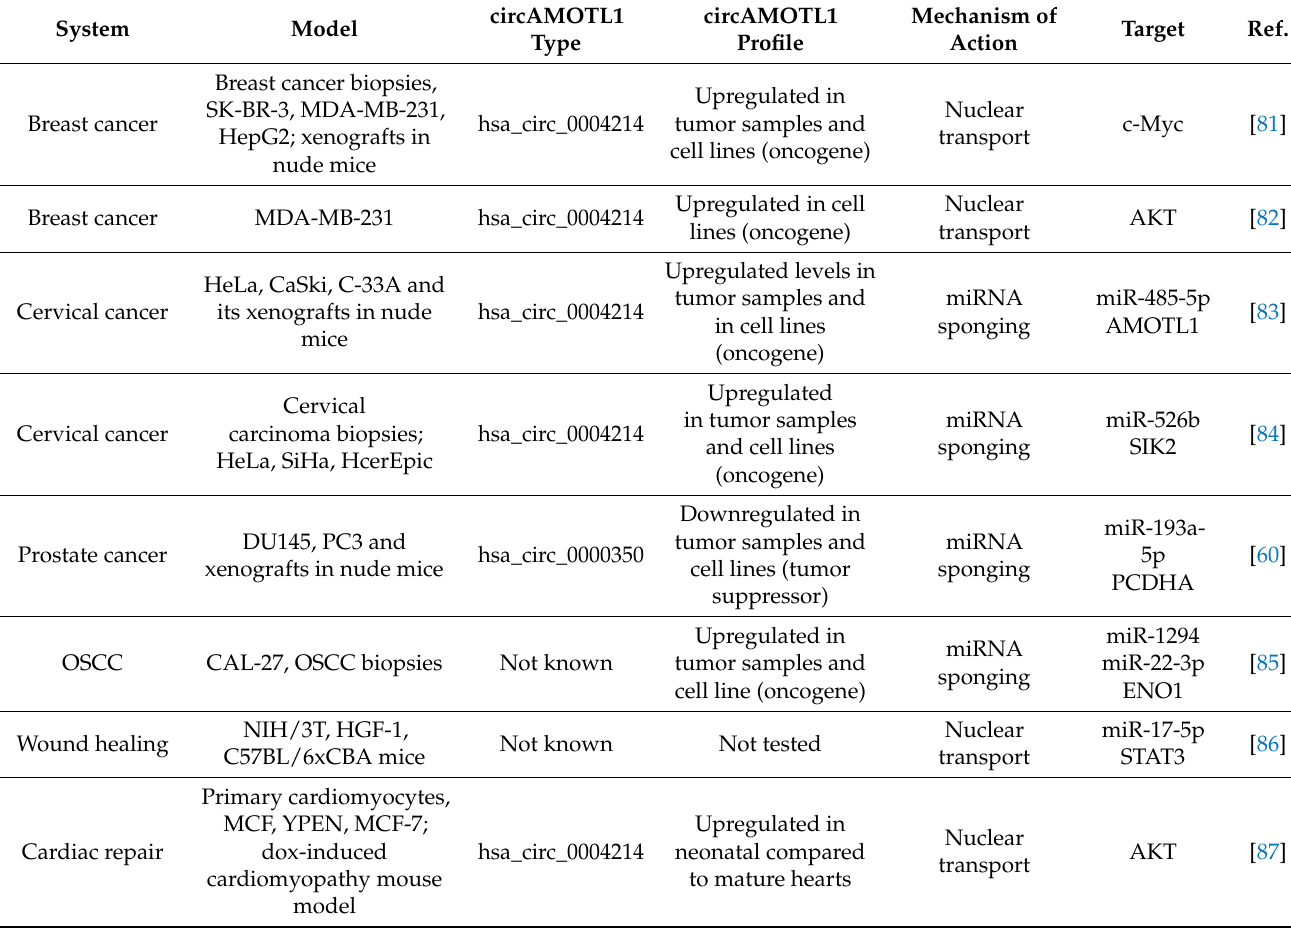
Table 1. Outline of circAMOTL1